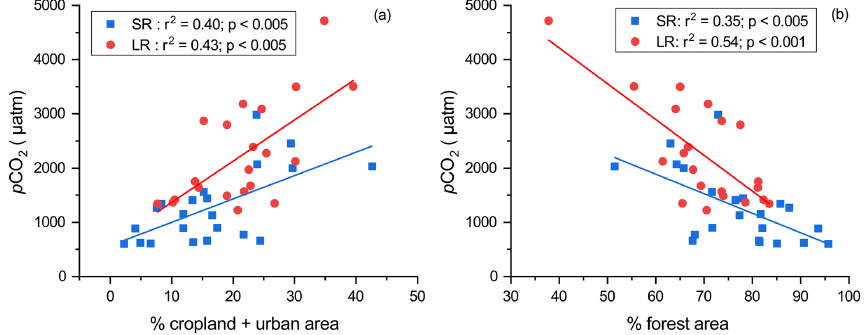
Figure 6. (a) The relationship between yearly average p CO 2 at each site and the percentage of cropland and urban area combined; (b) the relationship between yearly average p CO 2 at each site and the percentage of forest